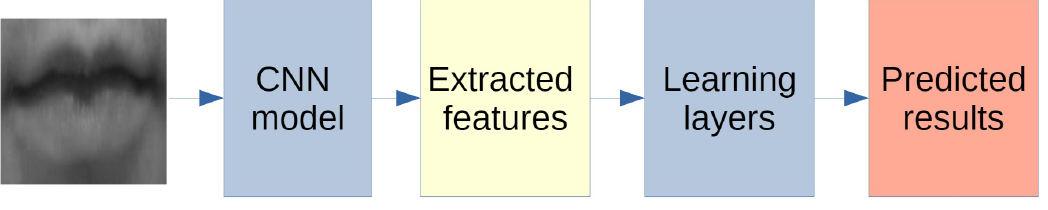
Figure 3. General scheme of our